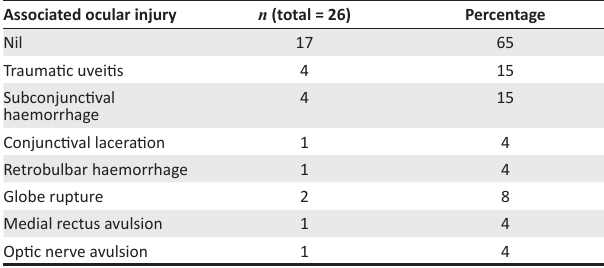
TABLE 3: Associated ocular